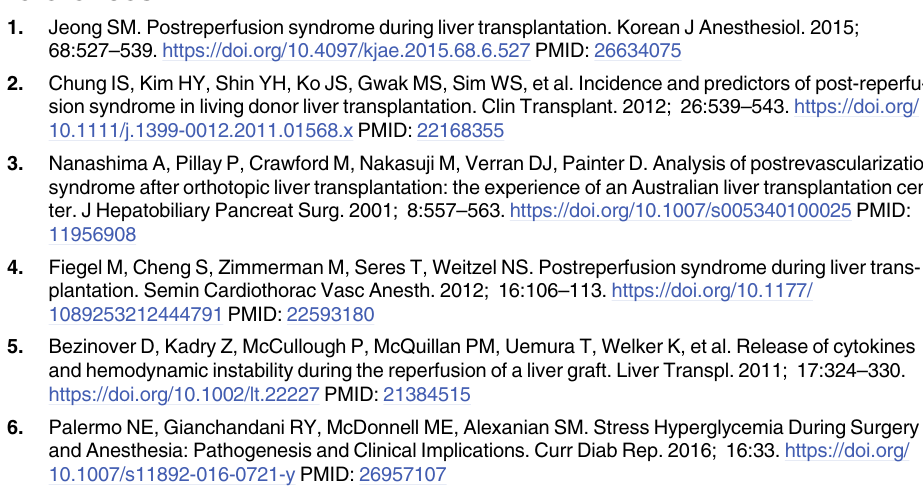
S3 Table. The rates of new-onset diabetes mellitus during the follow-up period and early bacteremia during the first 4 weeks postoperatively in PS-matched patients with and with- out PRS. S4 Table. The rates of pre-transplant DM and post-transplant new-onset DM by LDLT eti- ology in PS-matched